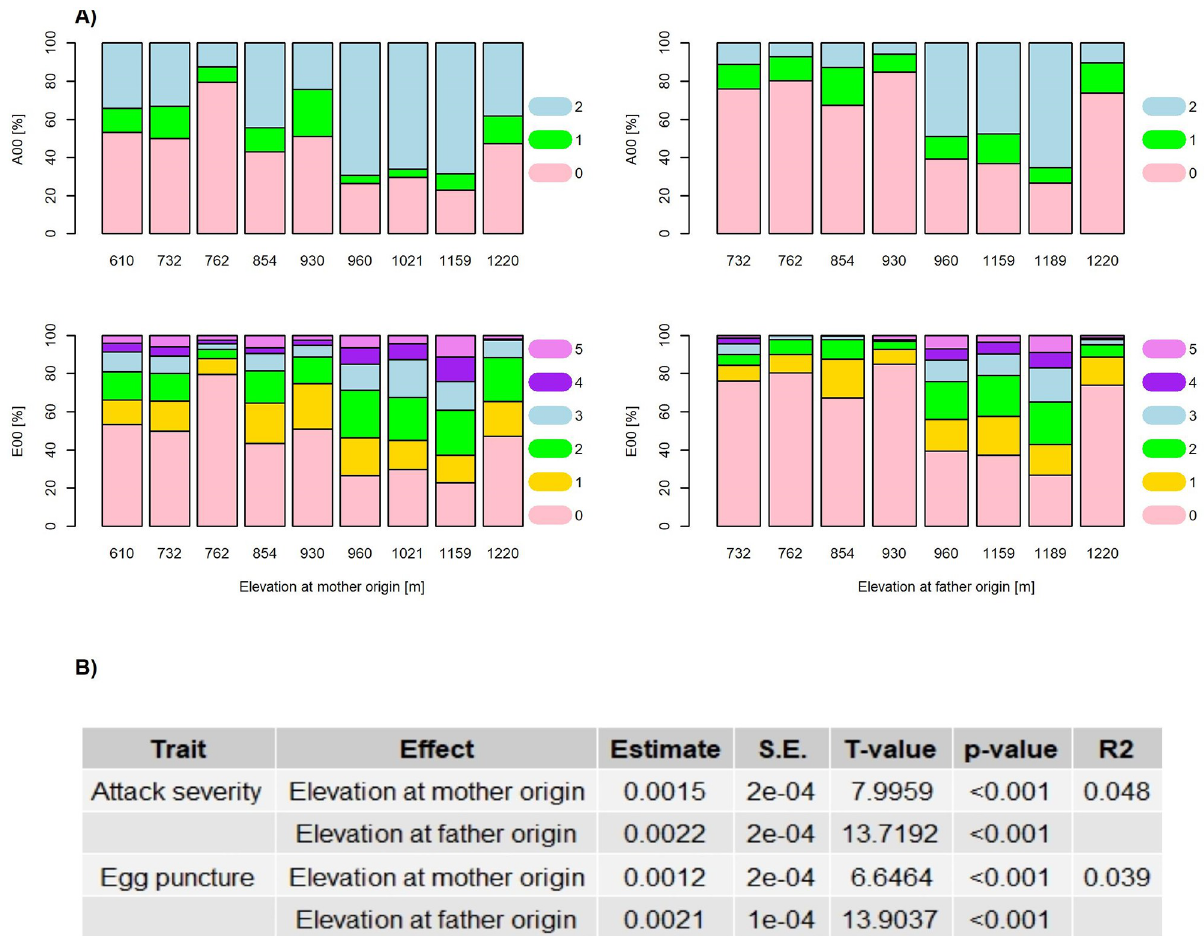
Fig 3. Phenotypic distributions of attack severity and egg puncture occurrences and their significance according to parental origins. A) The distribution of attack severity (A00, upper row) and egg punctures occurrences (E00, lower row) in the Interior spruce progenies (42 families) according to elevation at mother origin (left column) or at father origin (right column) is shown. These 42 controlled crosses were generated by mating resistant with resistant, resistant with susceptible, and susceptible with susceptible parents. The ranking in terms of weevil resistance of the individual Interior spruce parents is known and was done previously [13]. Attack severity increases from 0 to class 2. Egg puncture occurrence increases from 0 to class 5. The evaluation of attack severity and of egg puncture occurrence was done following artificial weevil infestation of the spruce resistance trial. B) Statistical significance of mother/father origin on attack severity and egg puncture occurrence is obtained from ordinal logistic regression. S.E. represents the standard error and R 2 the proportion of total variance explained by the model as pseudo R 2 .